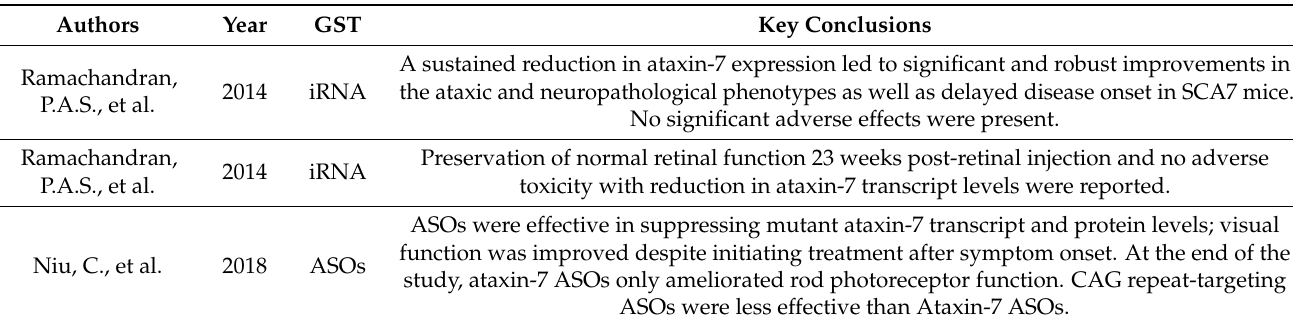
Table 3. Key conclusions from data extraction sheet—SCA7